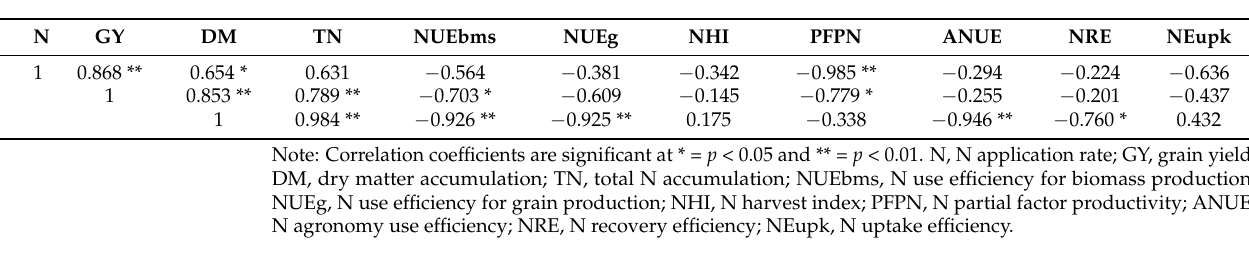
Table 6. The correlations between annual cereal GY, DM and nitrogen accumulation and